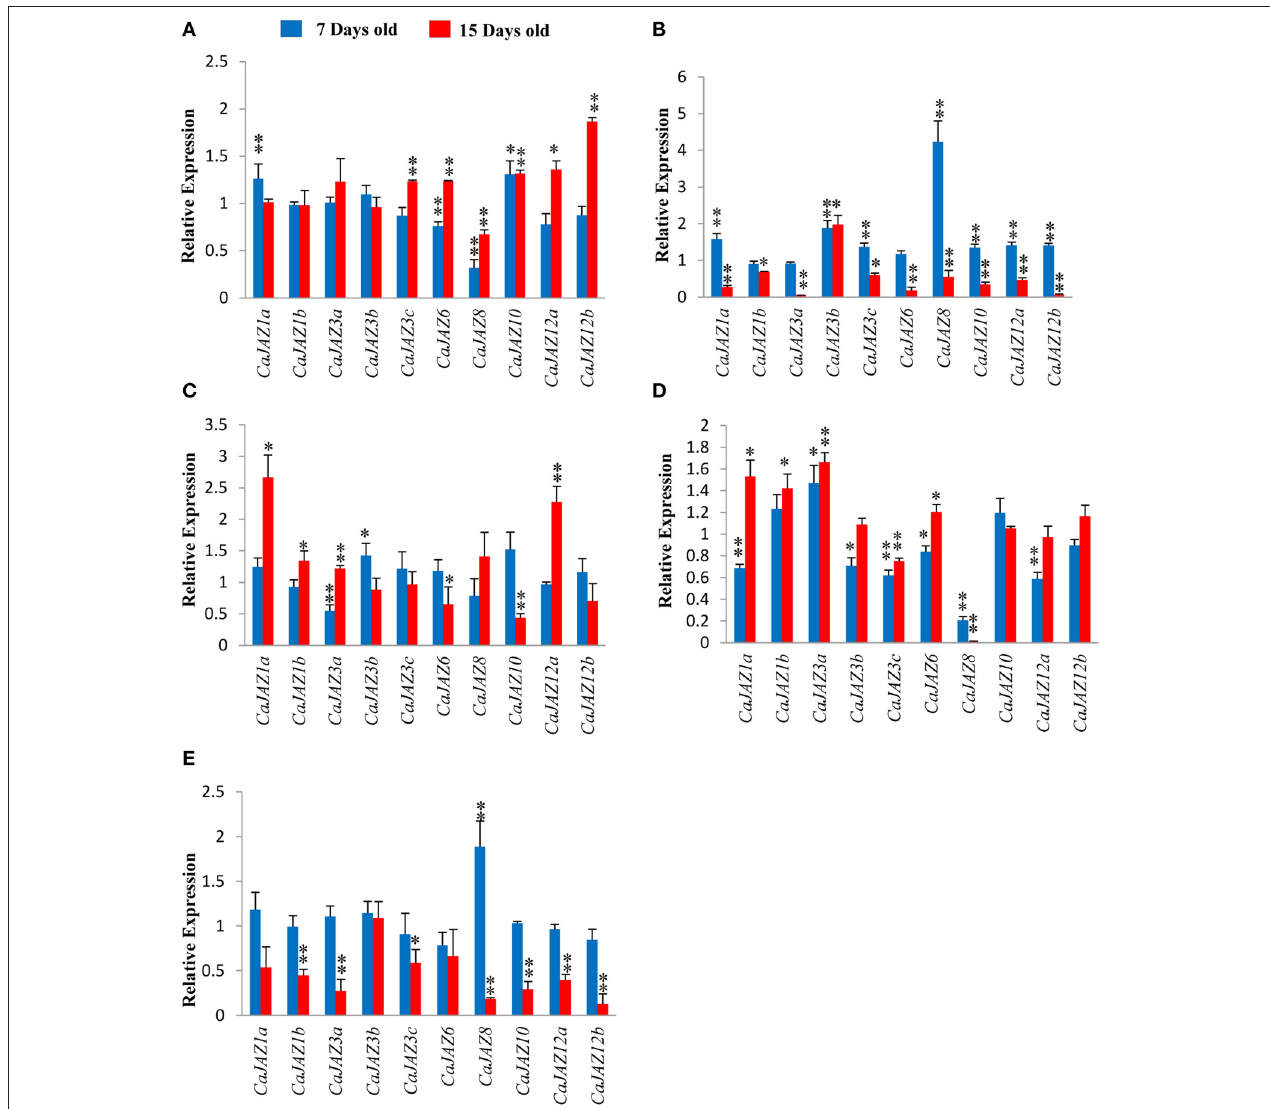
FIGURE 7 | Relative expression profile of CaJAZ genes under (A) N, (B) P, (C) K, (D) Fe, and (E) Zn deficiency after 7 (early response) and 15 days (late response) of the respective stress treatment in chickpea root. qRT -PCR was used for quantitation of gene expression. Each bar shows the average of three biological replicates. Relative mRNA levels in treated plants were calculated using unstressed plants as control. EF1-alpha gene was taken as endogenous control. ( * p < 0.05 , ** p < 0.01